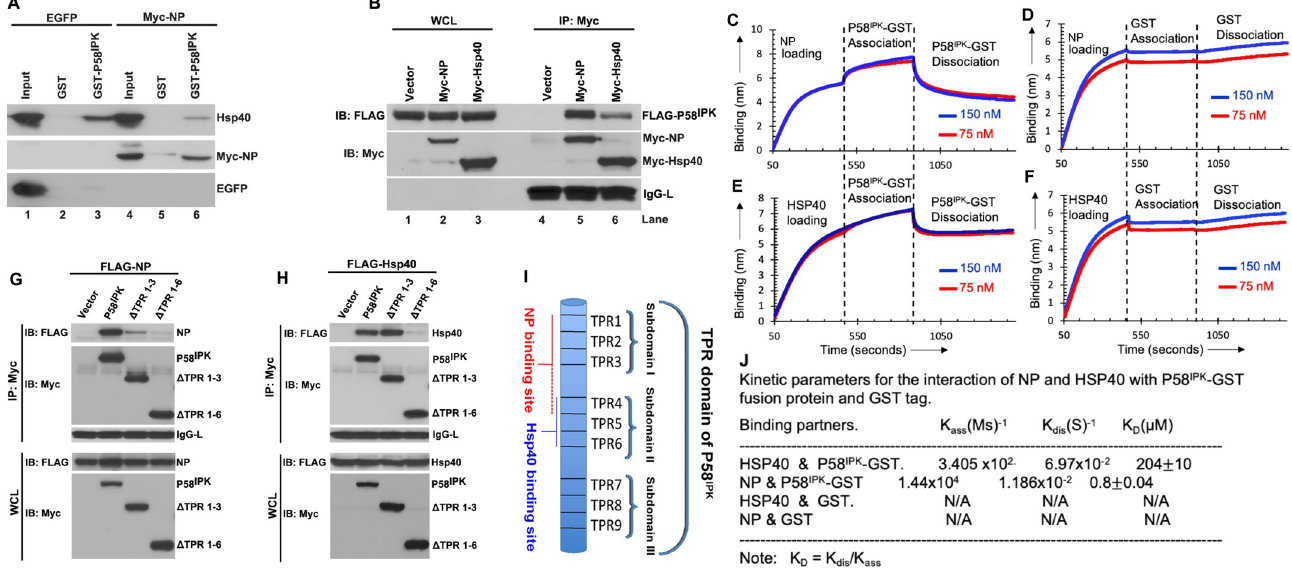
Fig 2. NP releases P58 IPK from its negative regulator Hsp40. A . Bacterially expressed and purified GST or GST-P58 IPK fusion proteins were incubated with Glutathione Sepharose beads. The beads were washed and further incubated with the lysates from HEK293T cells, stably expressing either EGFP (lanes 1–3) or Myc-NP (lanes 4–6). The bound material eluted from washed beads was examined by western blot analysis using appropriate antibodies. Input represents the whole cell lysate. B. HEK293T cells were co-transfected with plasmids expressing FLAG-P58 IPK along with either Myc-Hsp40 or Myc-NP. The cell lysates were immunoprecipitated using anti-Myc antibody. The western blot analysis of the whole cell lysate (WCL) (lanes 1–3) and immunoprecipiated material (lanes 4–6) was carried out using appropriate antibodies. C, D, E and F . Representative BLI sensograms showing over time association and dissociation of N protein with GST-P58 IPK (C), N protein with GST tag (D), HSP40 with GST-P58 IPK (E) and HSP40 with GST tag (F). The sensograms were generated at two concentrations of GST-P58 IPK and GST tag, shown by red and blue color in panels C-F (see materials and methods for details). G. HEK293T cells were cotransfected with plasmids expressing FLAG-NP or Myc tagged wild type P58 IPK or P58 IPK mutants lacking either subdomain I composed of TPR repeats 1–3 ( Δ TPR1-3) or both subdomains I and II composed of TPR repeats 1–6 ( Δ TPR1-6). Cell lysates were Immunoprecipitated using anti-Myc antibody. Western blot analysis of the whole cell lysate (WCL) or immunoprecipitated material was carried out using either anti-FLAG or anti-Myc antibodies, as shown. H . The experiment shown in this panel was carried out exactly as in panel C except FLAG-NP was replaced with FLAG-Hsp40. I . Schematic representation of TPR domain of P58 IPK . J . The kinetic profiles from panels C-F were analyzed for the calculation of binding parameters, as mentioned in Materials and Methods. Five percent of the calculated K D value was added as standard deviation. lanes 7,8 and 9 in Fig 1D). To further confirm that NP impacted the Hsp40-P58 IPK interaction, bacterially expressed and purified GST-P58 IPK fusion protein was immobilized on Glutathione Sepharose beads. The beads were incubated with HEK293T cell lysates stably expressing either EGFP or NP, as mentioned in Materials and Methods. An examination of the GST pull-down cell lysates expressing EGFP. However, the interaction was impacted in cell lysates expressing NP (compare lane 6 with lane 3 in Fig 2A). The co-purification of both NP and Hsp40 with the GST-P58 IPK suggests that NP likely competed with the Hsp40 for binding to GST-P58 IPK . We were co-transfected with plasmids expressing FLAG tagged P58 IPK along with either Myc tagged NP or Myc tagged Hsp40. Cell lysates were immunoprecipitated with anti-Myc anti- body and the binding of FLAG tagged P58 IPK was examined by western blot analysis using